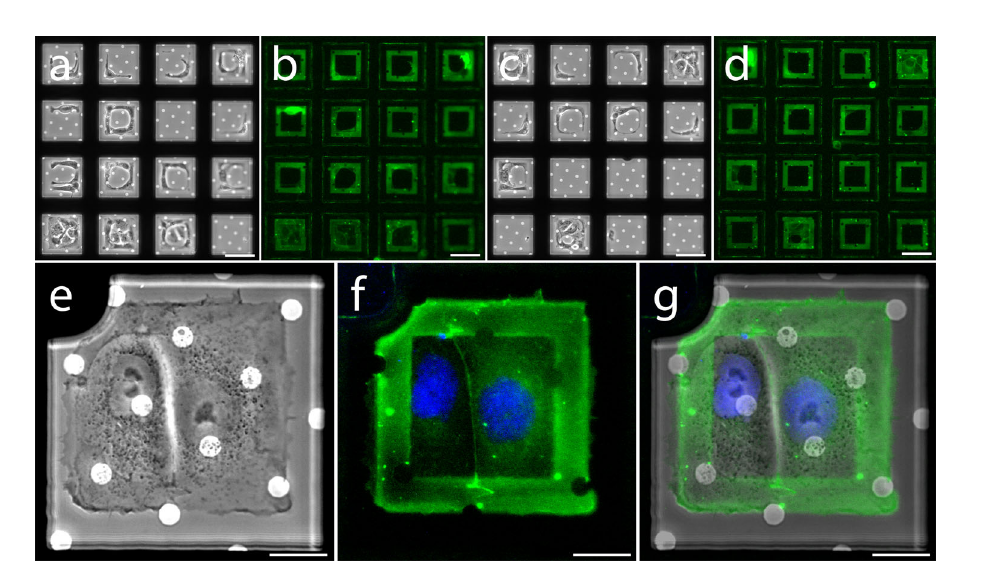
fl uorescence images of patterned areas are shown in the top panels. bars, 60 µ m ( a – d ) and 20 µ m ( e – g ). All ECM patterns are 66.5×66.5 µ m.